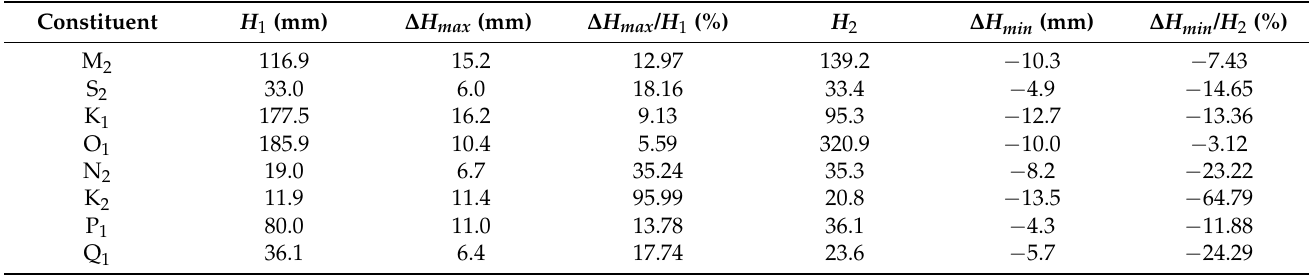
Table 4. The extreme ratio of amplitude difference to the corrected amplitude of the eight major tides in the South China Sea. H 1 and H 2 are the corrected amplitudes.